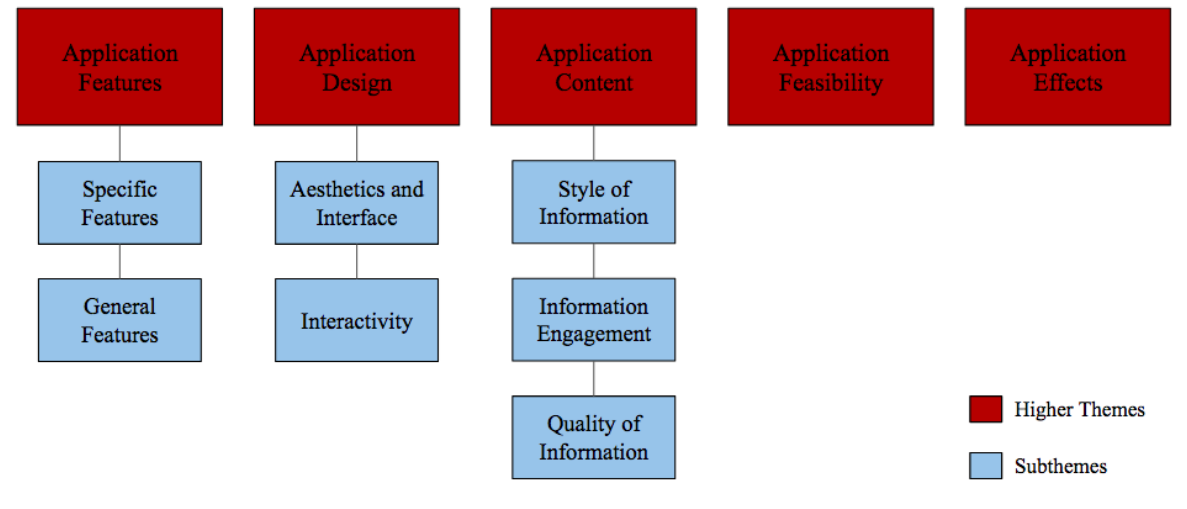
Figure 3. Visual representation of the five overarching themes and their respective subthemes, which resulted from the thematic